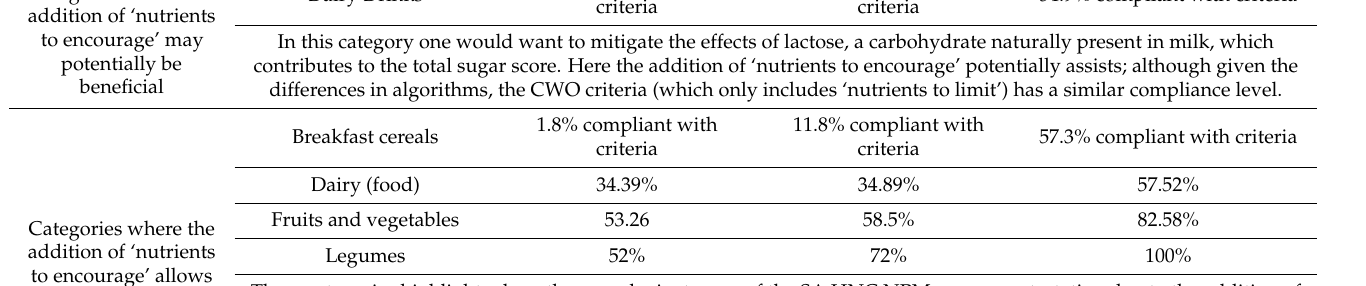
Table 1. Qualitative table reflecting how the addition of ‘nutrients to encourage’ affects NPM leniency, in terms of the proportion of products compliant (i.e., that fall beneath the thresholds and are not deemed ‘unhealthy’). Highlighted Food